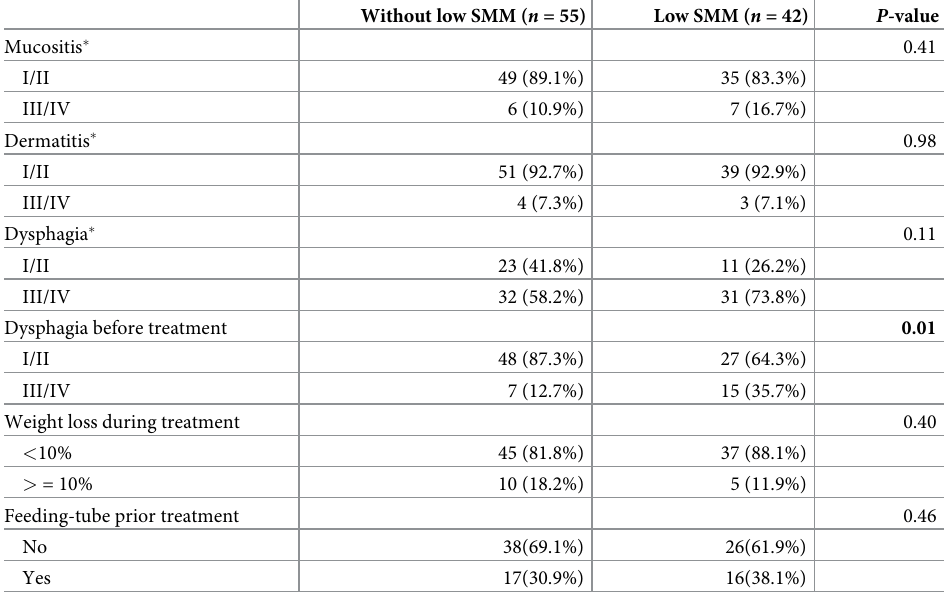
Table 3. Toxicities and feeding status according to SMM status.